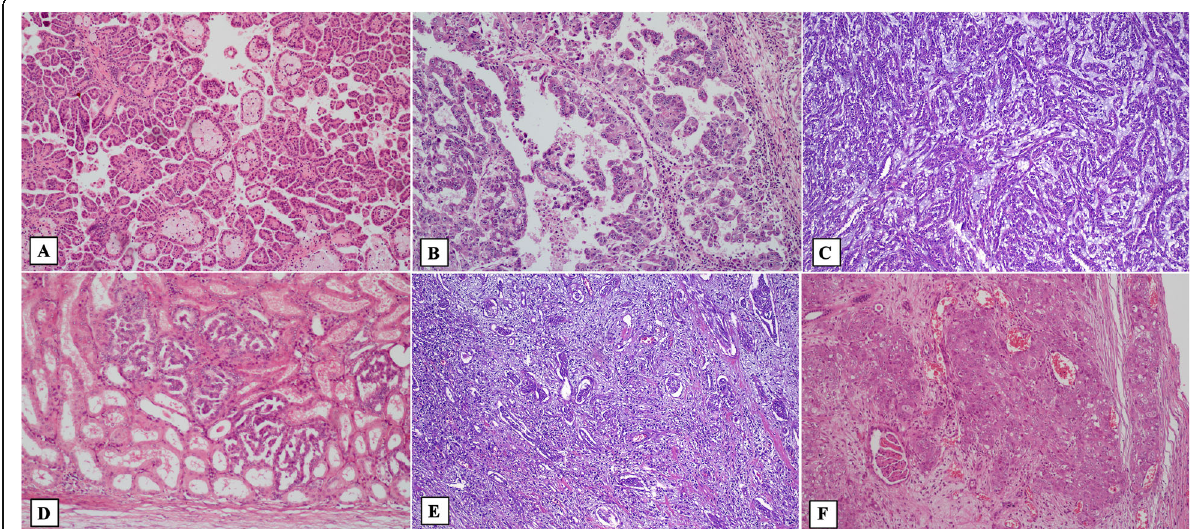
Fig. 3 Renal cell carcinomas with papillary features and some of their differential diagnoses. Type 1 Papillary RCC exhibits papillae lined by a single layer of cells with scant pale cytoplasm and low nucleolar grade. Foamy macrophages within fibrovasculares cores are a common finding ( a HE, 100x). Type 2 Papillary RCC displays nuclear pseudostratification with cells containing voluminous eosinophilic cytoplasm and generally high nucleolar grade. In this case, such nucleolar prominence imposes further evaluation to exclude fumarate hydratase deficiency ( b HE, 100x). Mucinous tubular and spindle cell carcinoma consists of tightly packed tubular component lined by cuboidal cells that transitions into a bland spindle cell component, set in a variable amount of mucinous / myxoid stroma ( c HE, 100x). Papillary adenoma shows identical architectural and cytologic features to classic type 1 PRCC but the diagnosis required low nuclear grade, absent fibrous capsule and size ≤ 15 mm ( d HE, 100x). Collecting duct carcinoma consists in a high-grade adenocarcinoma that usually show tubular morphology, and highly infiltrative growth with associated desmoplastic reaction ( e HE, 40x). Medullary carcinoma – solid areas of highly infiltrative high-grade carcinoma inducing desmoplastic reaction in renal cortex – note preexistent tubules and glomerulus intermixed with the infiltrative tumor. This was an advanced stage RCC diagnosed in a 25-year-old female patient with sickle cell anemia ( f HE,